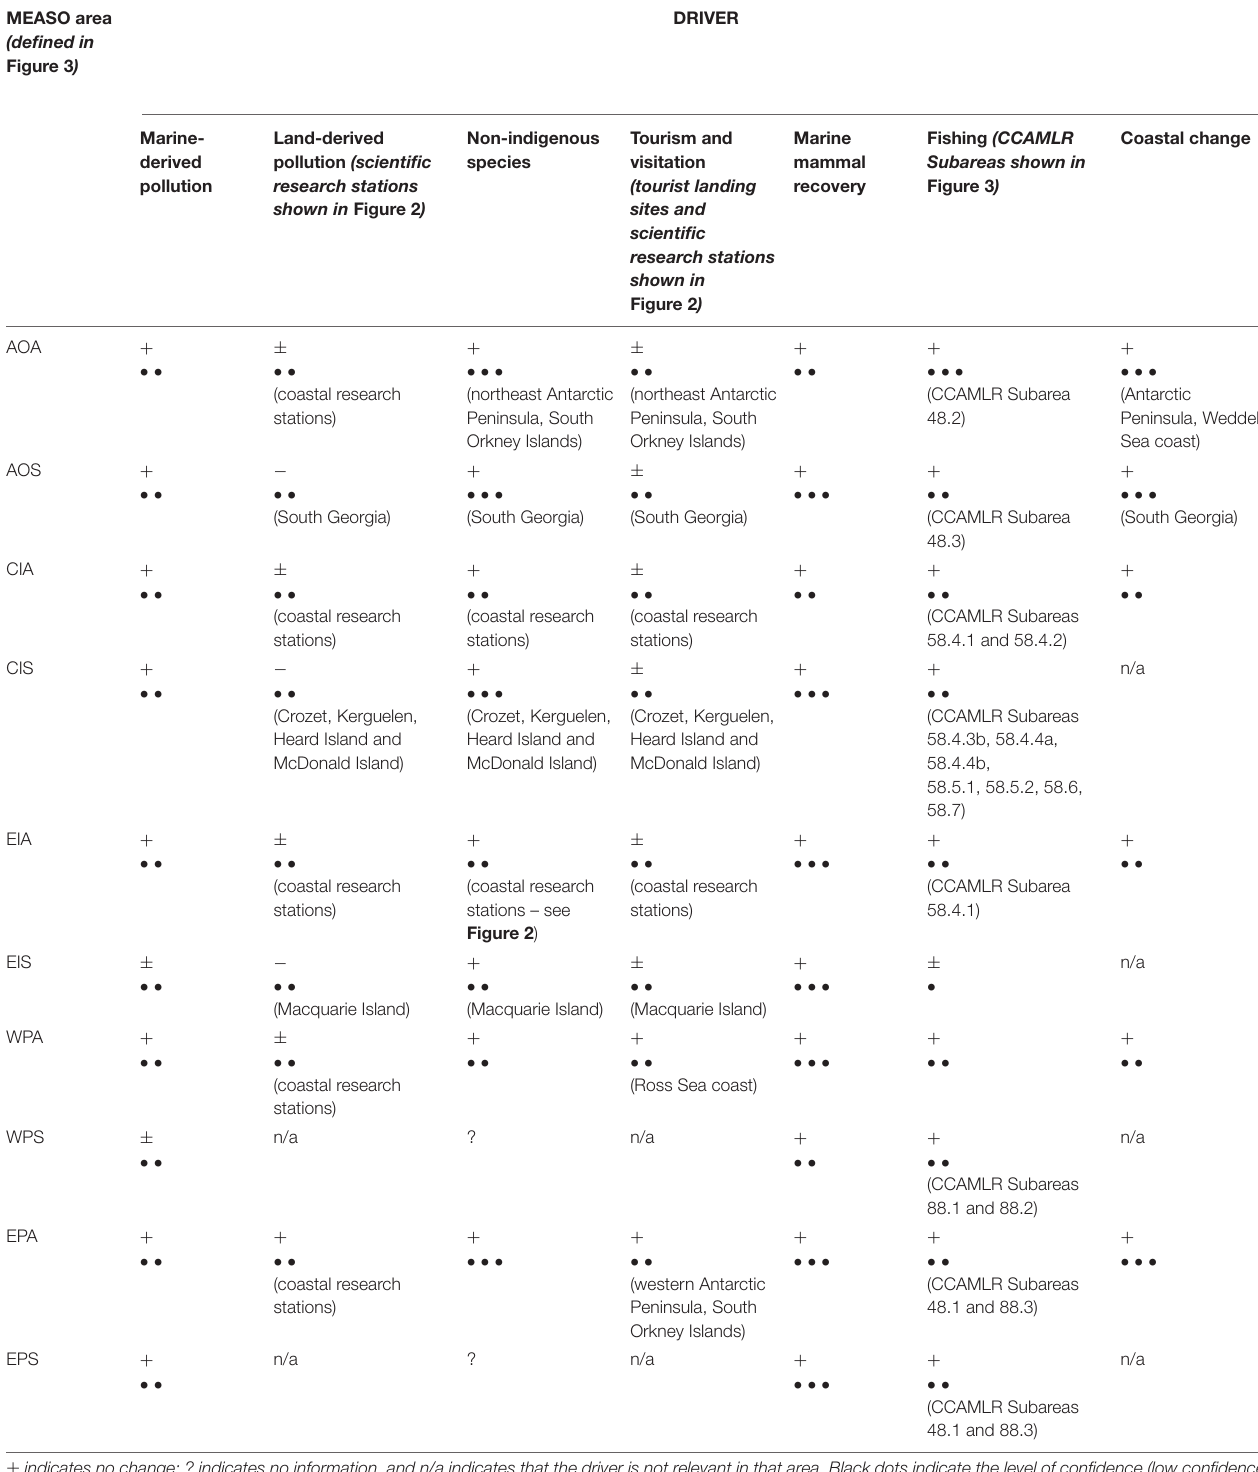
TABLE 1 | Assessment of the projected increase ( + ) or decrease ( − ) of the influence of local drivers within MEASO areas (based on information provided in the previous sections). MEASO area (defined in Figure 3